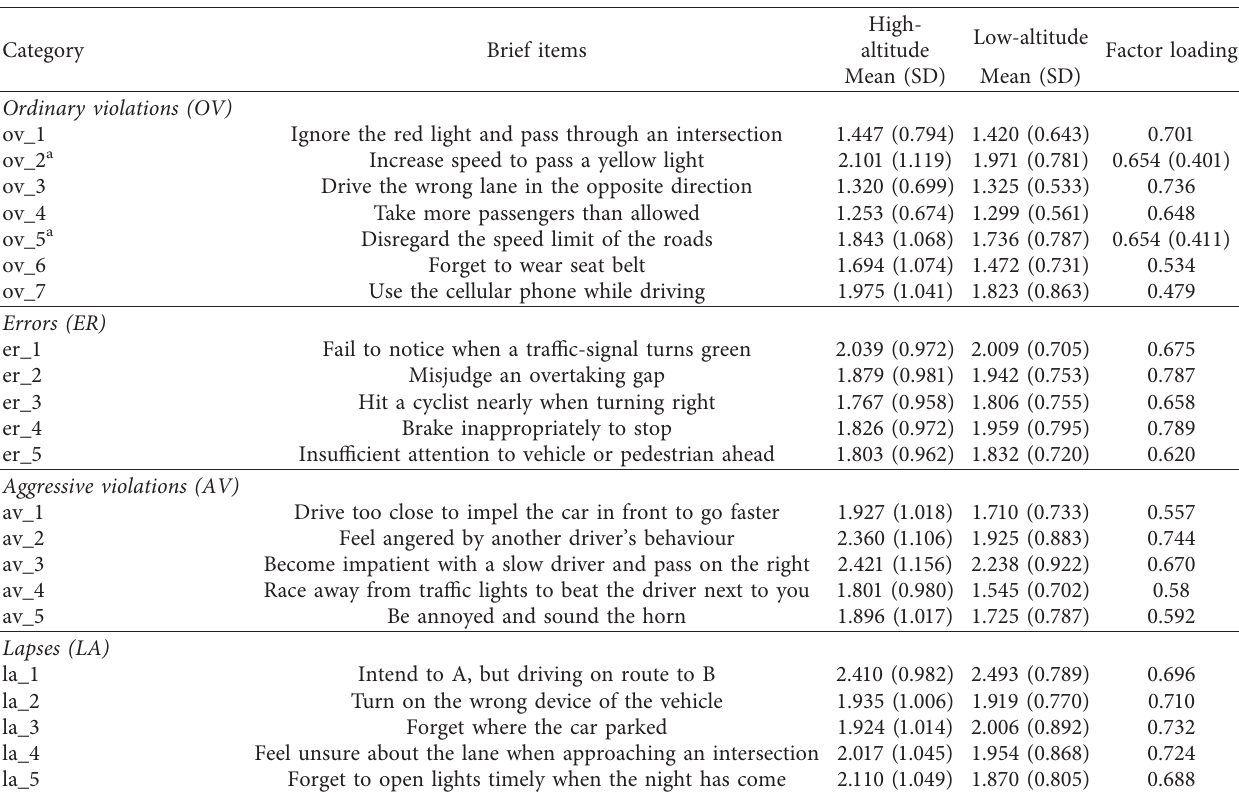
Table 4: Factor loading and